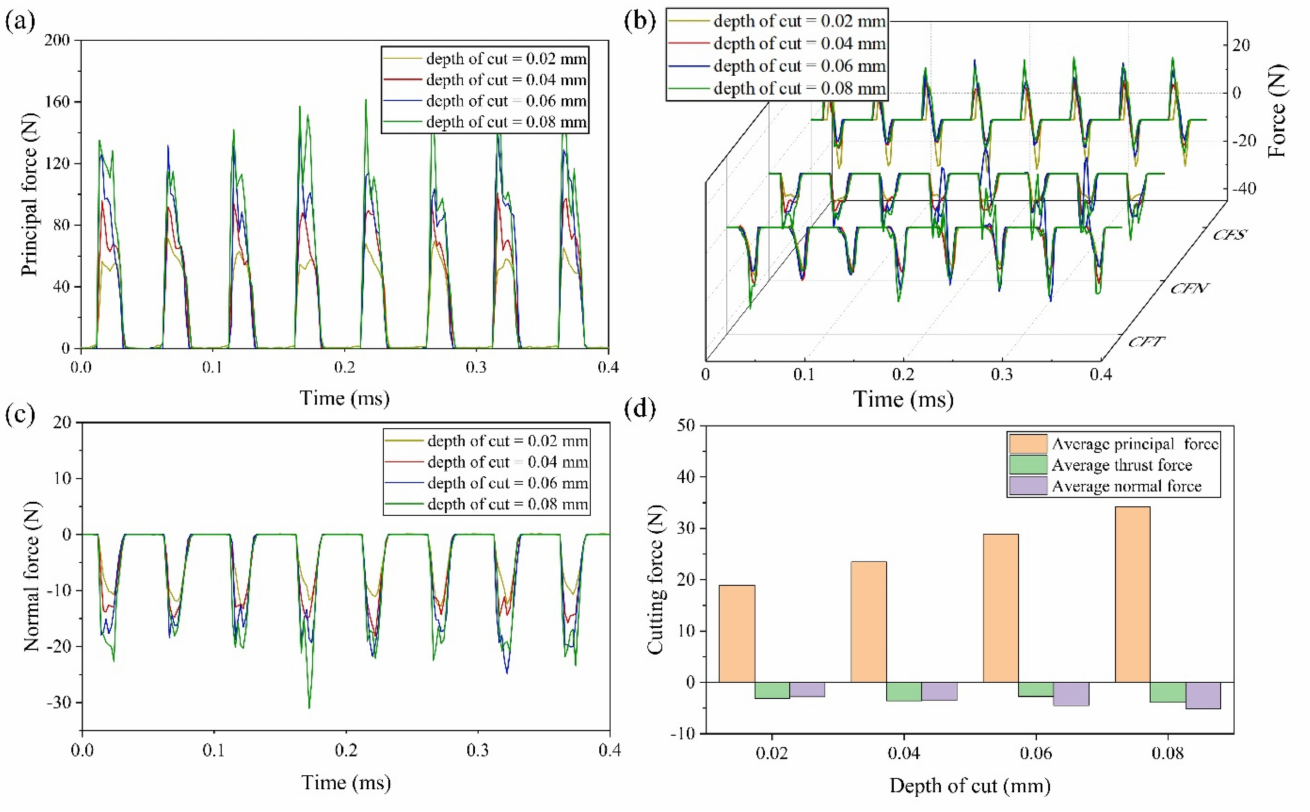
Figure 10. Results of cutting force with various cutting depths ( a ) principal force ( b ) thrust force ( c ) normal force ( d ) average cutting force.